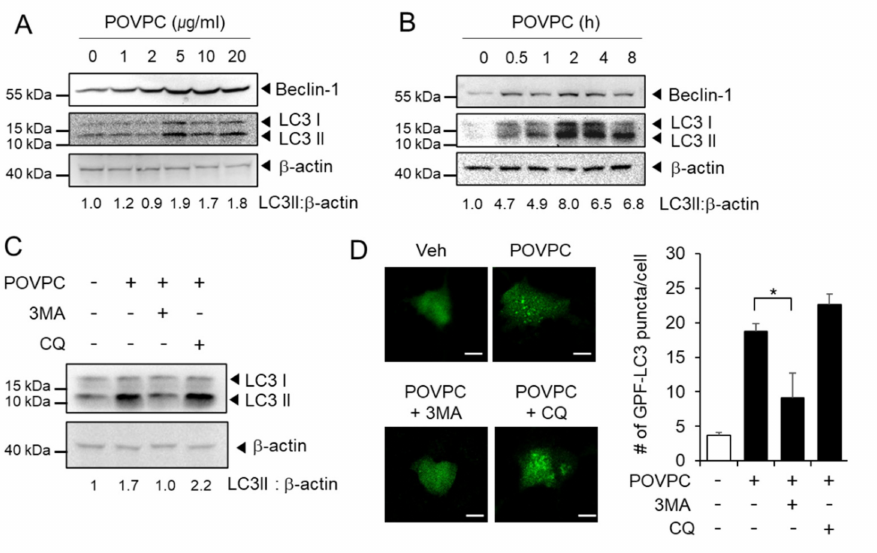
Figure 3. POVPC induces autophagic flux in cancer cells. ( A ) HepG2 cells were treated with the specified doses of POVPC for 8 h. ( B ) MCF7 cells were treated with 5 µ g/mL of POVPC for the indicated time periods. Proteins were determined by immunoblotting as indicated with β -actin as the loading control. ( C ) HepG2 cells were pretreated with 3-methyladenine (3MA, 10 mM) and chloroquine (CQ, 5 µ M) for 1 h and then treated with 5 µ g/mL of POVPC for 8 h. The levels of LC3 were determined by immunoblotting. + means corresponding treatment and - means vehicle treatment. ( D ) HepG2 cells expressing GFP-LC3 were pretreated with 3MA (10 mM) or CQ (5 µ M) for 1 h and then treated with 5 µ g/mL of POVPC for 8 h. The representative fluorescence images are presented (left). The scale bar represents 20 µ m. The bar graph shows the number of GFP-LC3 puncta in each cell (right). Values in line graphs represent the mean ± SEM ( n = 3). *, p <